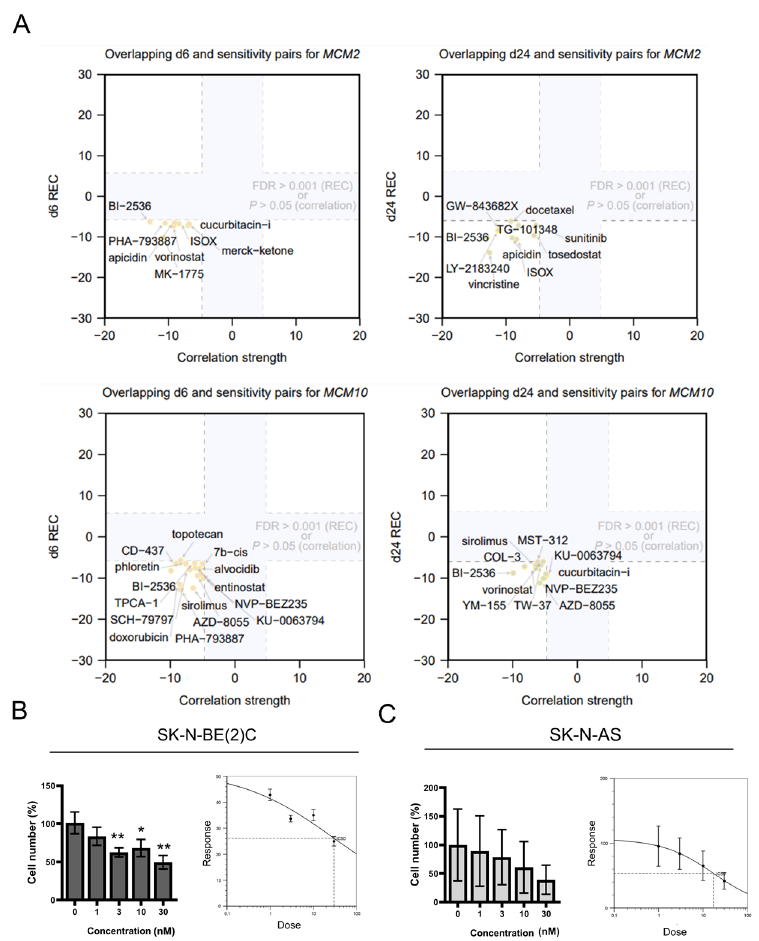
Figure 3. Discovery of compounds targeting MCM2 and MCM10: ( A ) Comparison between gene– sensitivity ( x -axis) and perturbation–gene relationships ( y -axis; REC analysis of perturbation profiles for 6 (d6) or 24 (d24) h) for genes MCM2 and MCM10 and small molecules. High expression was correlated with sensitivity to BI-2536 for both d6 and d24 comparison (n = 8 for d6 and n = 10 for d24; false discovery rate (FDR) ≤ 0.001 for REC analysis; p ≤ 0.05 for sensitivity correlation analysis). ( B , C ) Cell viability assay of SK-N-BE(2)C ( B ) and SK-N-AS ( C ) cells treated with BI-2536. Cell death was positively correlated with increasing concentrations of BI-2536 (from 0 to 30 nM). The half maximal inhibitory concentration (IC 50 ) values were 28.23 and 17.30 nM for SK-N-BE(2)C and SK-N-AS cells, respectively (calculated and visualized using the IC 50 Calculator (https://www.aatbio.com/tools/ic50-calculator; (accessed on 28 April 2020)). * p < 0.05, ** p < 0.01, from two-tailed unpaired Student’s t -test to determine whether the mean value of a given group is equal to the corresponding DMSO alone group.